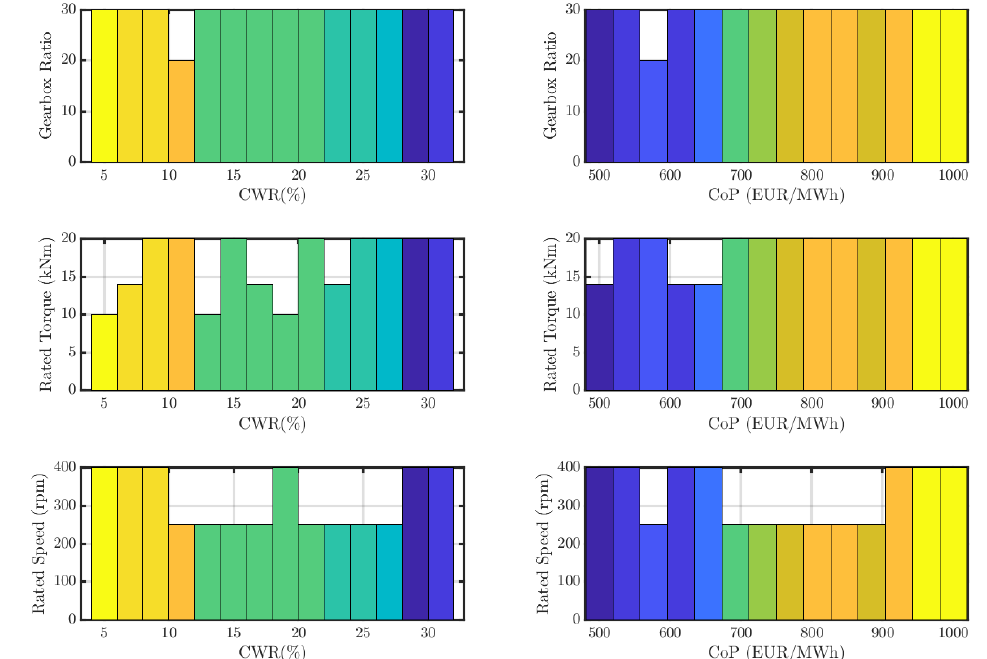
Figure 21. On the left: 14 individuals with the highest CWRs for each CWR-bin, with bars coloured proportionally to CWR. On the right: 14 individuals with lowest the CoPs for each CoP-bin, with bars coloured proportionally to 1/CoP.